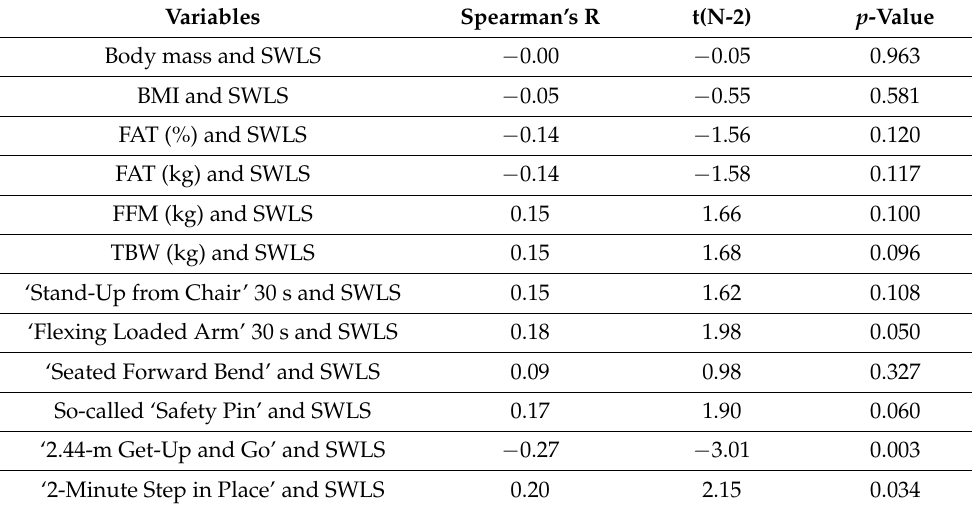
Table 4. Correlations between satisfaction with life (SWLS) and somatic indices and indicators of func- tional fitness among women participating in the “Healthy Active Senior” programme (Spearman’s correlation analysis).